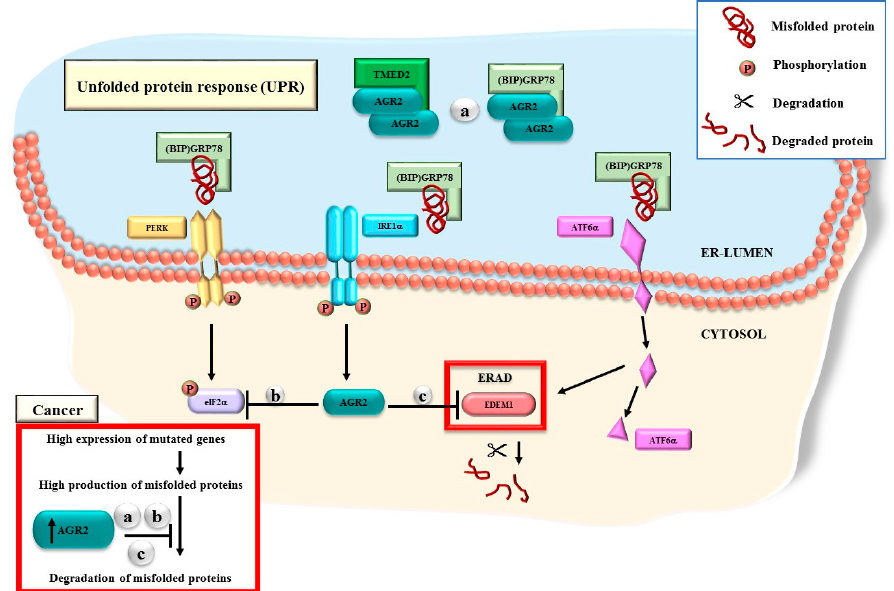
Figure 4. The mechanism of action for AGR2 in the UPR machinery. AGR2 has several roles in the UPR. ( a ) Dimeric AGR2 directly interact with GRp78 or TMED2 in the ER-lumen. ( b ) The AGR2 overexpression a ff ects the expression of phosphorylated eIF2 α . ( c ) The expression levels of